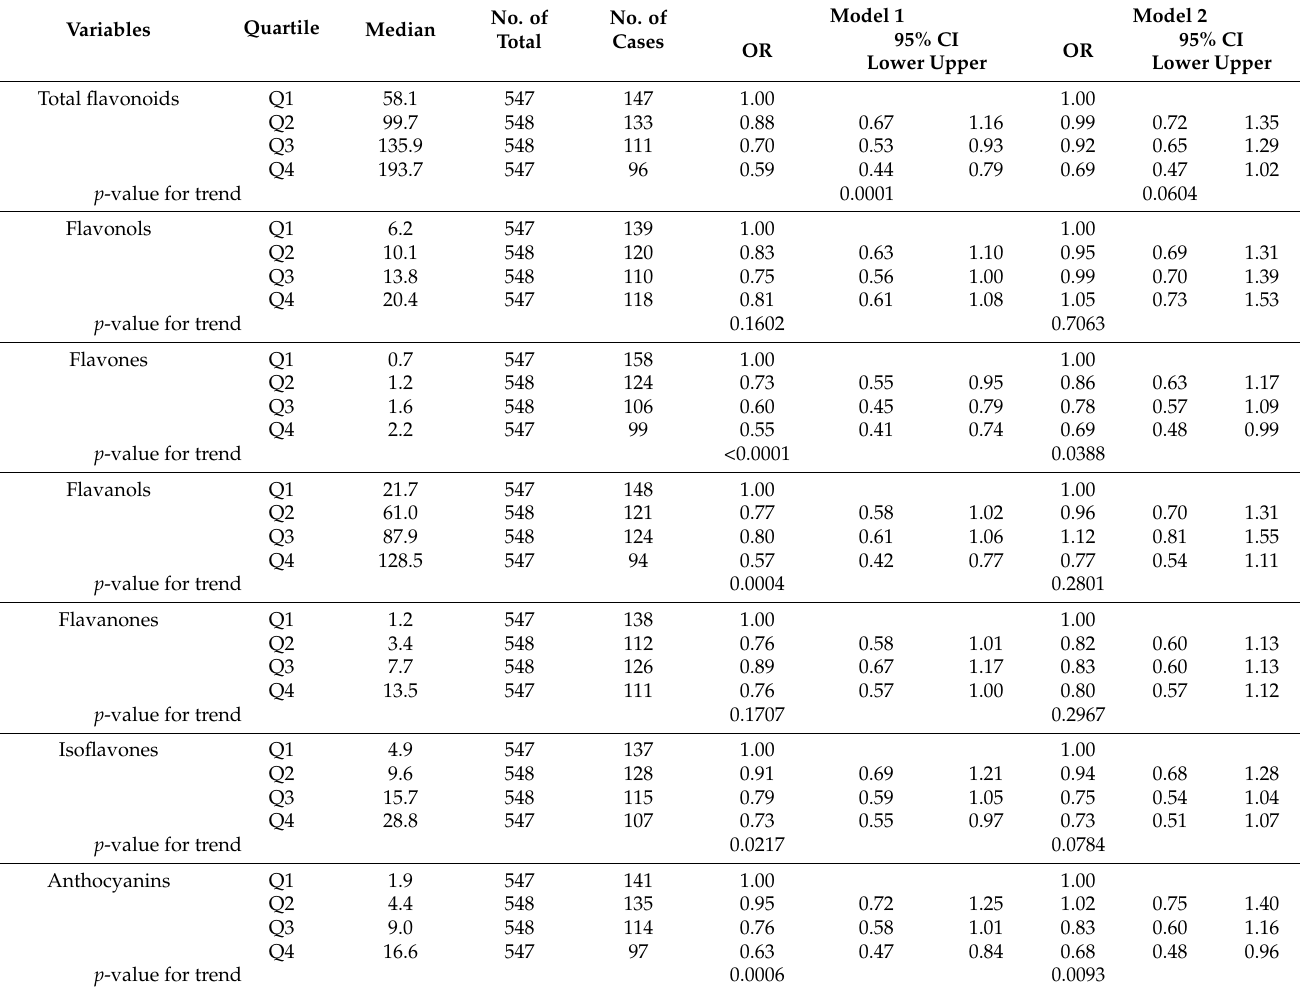
Table 3. Association between total flavonoids and subclass intake and prevalence of depressive symptoms in multivariate-adjusted logistic regression